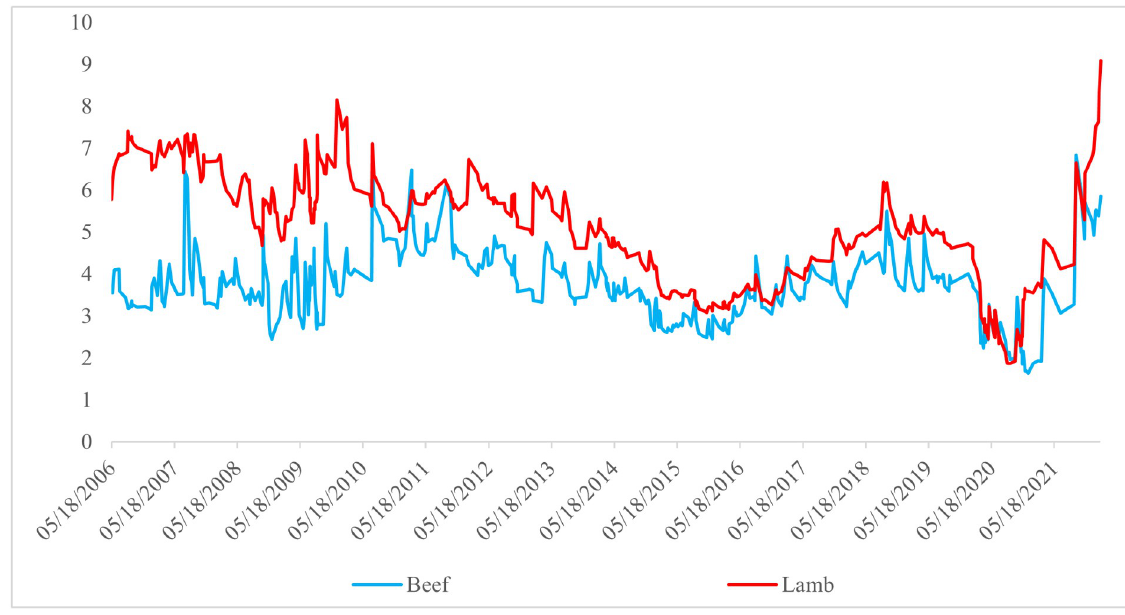
Fig 4. Time–varying conditional variances of beef and